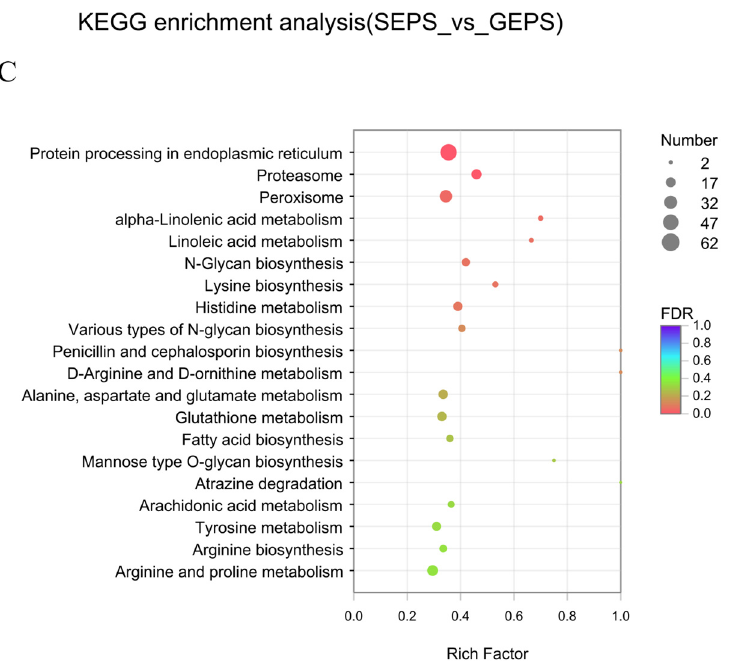
Figure 2. Enrichment analysis of DEGs between SEPS_48 and GEPS_48 comparison groups based on GO and KEGG pathway. The most enriched top 20 pathways terms. ( A ) GO enrichment column chart of DEGs. ( B ) KEGG annotation histogram of DEGs. ( C ) KEGG enrichment bubble chart of DEGs (the color represents the p -value, and the size of the bubble represents the number of enriched genes).